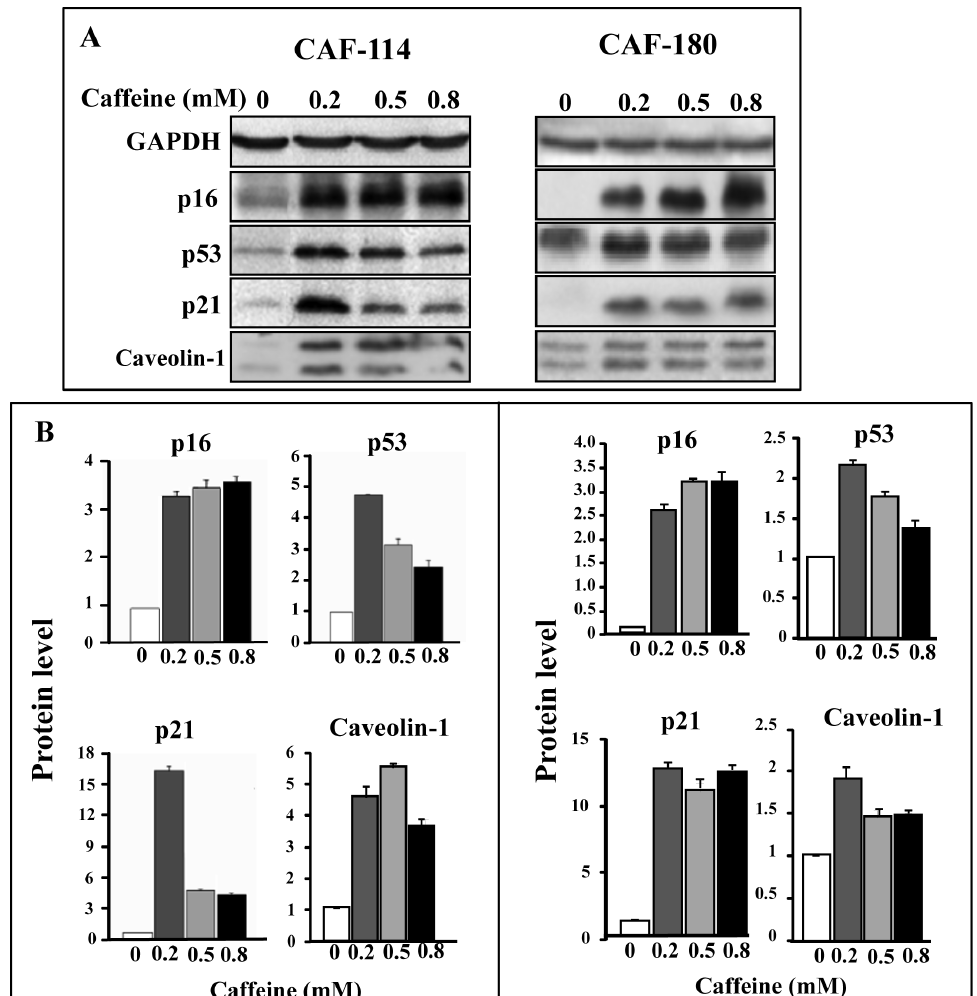
Figure 1. Caffeine up-regulates the expression of p16, p21, p53 and Cav-1. Cells were either sham treated or challenged with the indicated caffeine concentrations for 1 hr. Whole cell lysates were prepared and 50 m g of proteins were used for immunoblotting analysis using the indicated antibodies. (A) Immunoblots. (B) Histograms show the expression levels of the indicated proteins. The values were determined by densitometry and normalized against GAPDH. Error bars represent means 6 S.D.